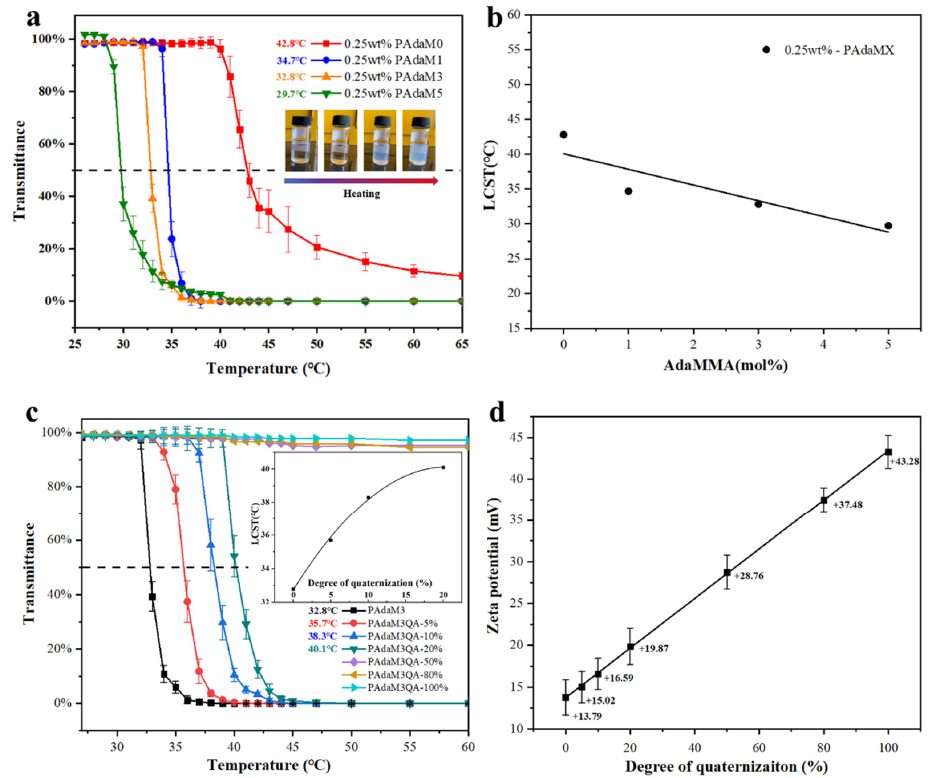
Figure 4. ( a ) The transmittance of 0.25 wt% PAdaMX solution; ( b ) the effect of AdaMMA addition on LCST of PAdaMX solution; ( c ) the transmittance of PAdaM3QA − X solution; ( d ) the zeta potential of PAdaM3QA − X solution with different degrees of quaternization.